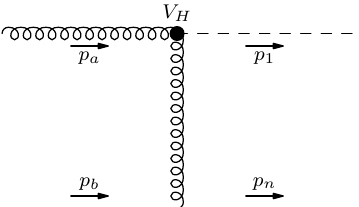
Figure 4. The tree-level diagram for the process gq → Hq . The straight solid line denotes an arbitrary light quark or